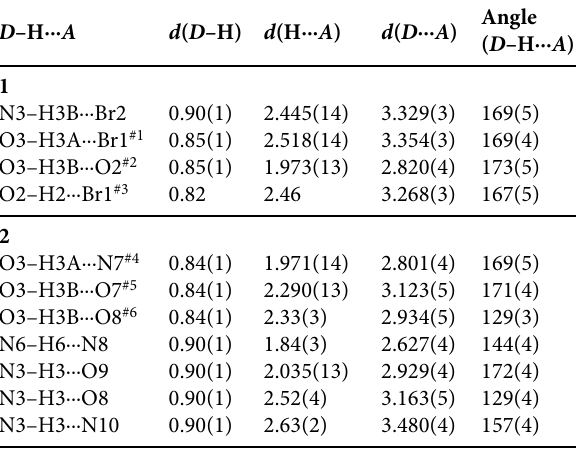
Figure 4. Molecular packing structure of complex 2 linked by hy- drogen bonds.